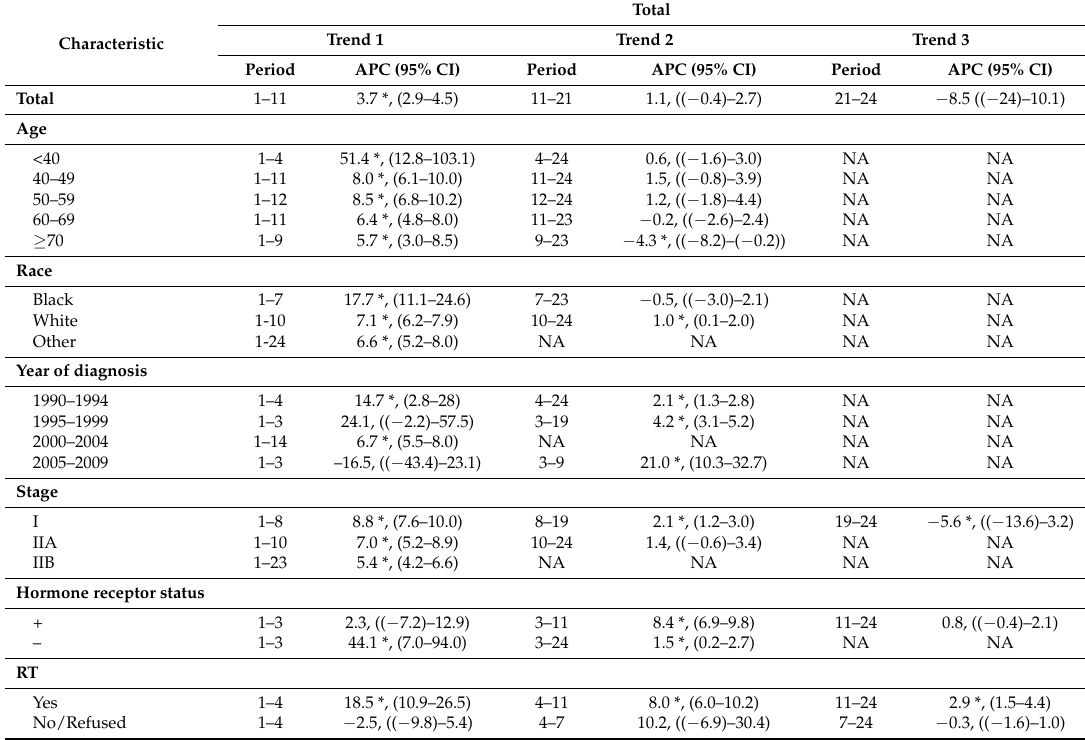
Table 2. Jointpoint regression for CBC incidence in patients with early stage